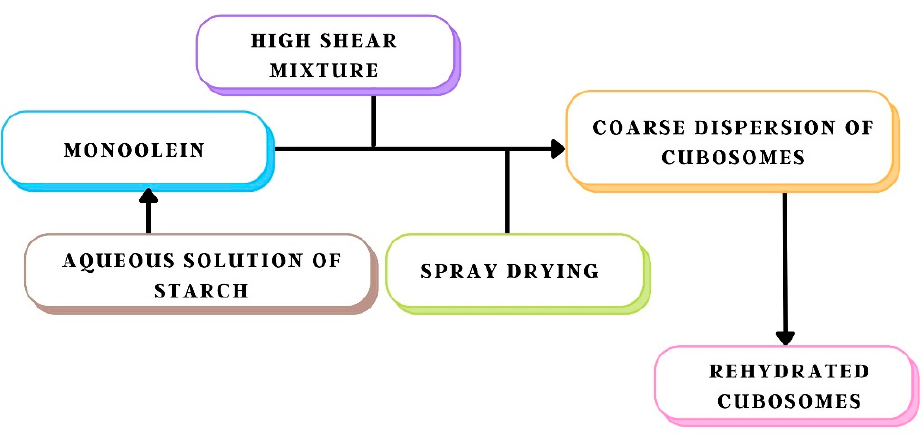
Figure 6. Schematic representation of the preparation of dry powder cubosomes. Table 5. Comparison of formulation techniques.